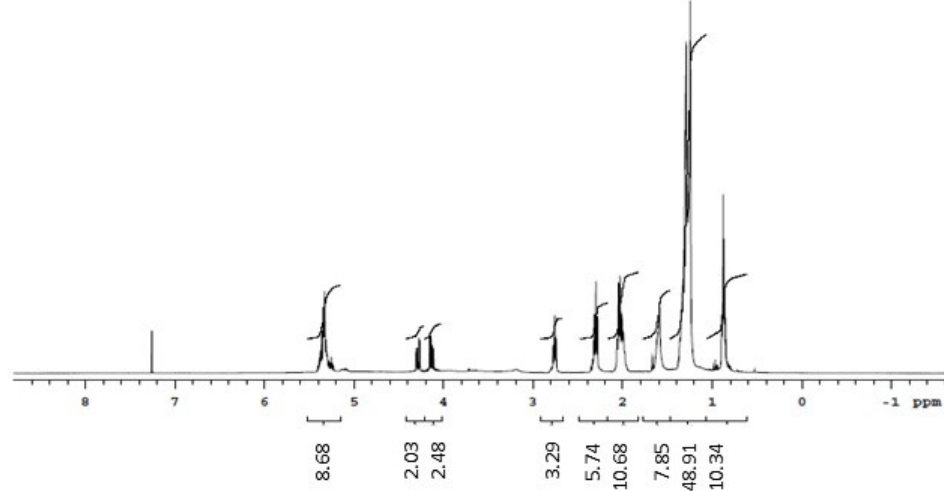
Figure 6. 1 H NMR spectrum (CDCl 3 , 300 MHz) of the biosurfactant from Chenopodium quinoa .